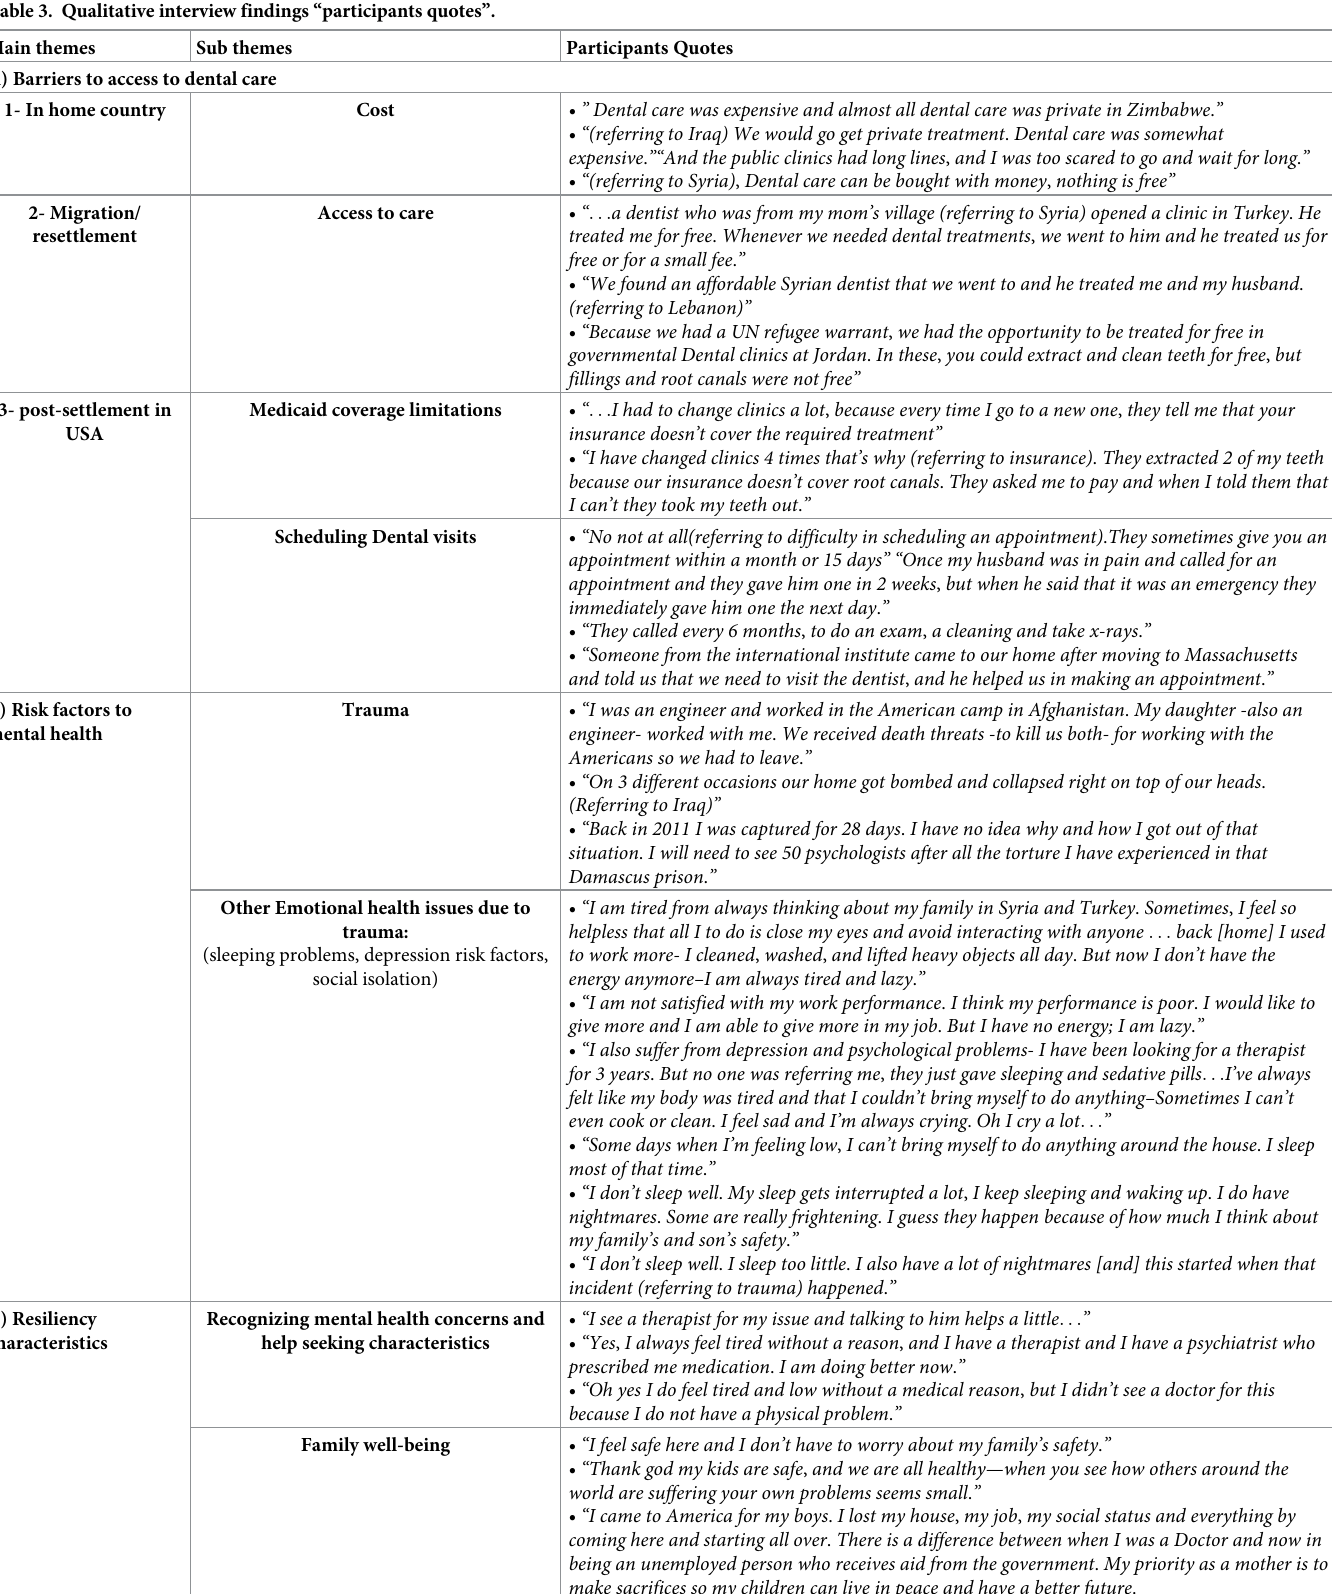
Table 3. Qualitative interview findings “participants